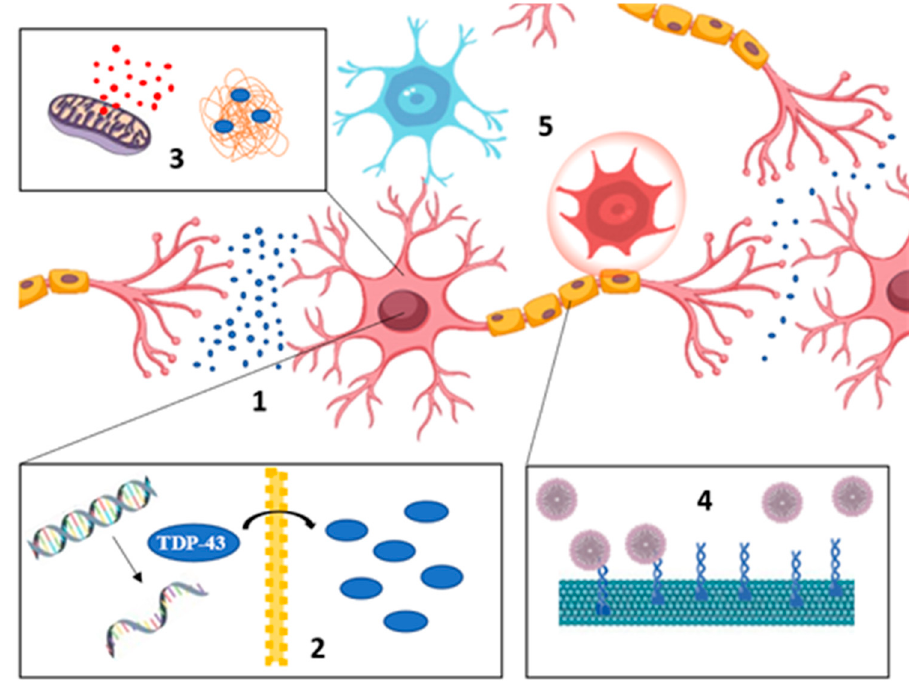
Figure 1. Main pathogenic pathways involved in amyotrophic lateral sclerosis (ALS). ( 1 ) Excitotoxicity due to an excessive glutamatergic activity, ( 2 ) impaired RNA metabolism, ( 3 ) accumulation of defective mitochondria and protein aggregates, ( 4 ) incorrect axonal transport, and ( 5 ) neu- roinflammation.